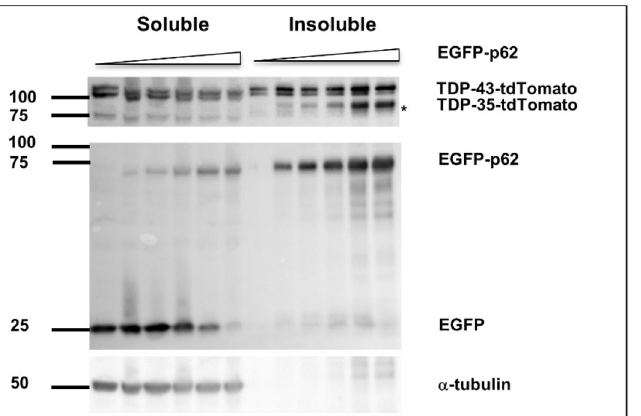
Figure 4. p62 expression induces TDP-43 cleavage to a 35-kDa fragment. Cells were transfected with constant TDP-43-tdTomato with increasing amounts of EGFP-p62 (0, 0.25, 0.5, 1, 1.5 or 2 μg) and decreasing amounts of EGFP (2, 1.75, 1.5, 1, 0.5 or 0 μg) to maintain consistent DNA amounts across transfection. Cells were then lysed in Triton-X buffer (soluble) and Triton-X insoluble pellets were solubilized with SDS (insoluble). Western blots for GFP, RFP and α-tubulin were performed as indicated. Image is representative of 3 independent